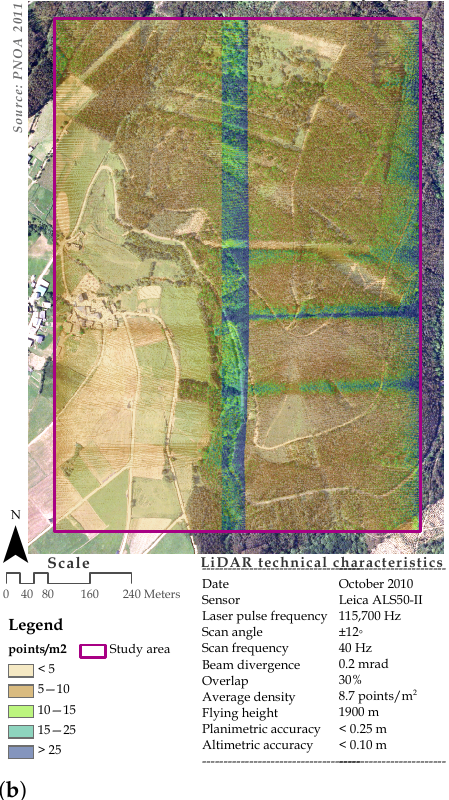
Figure 2. ( a ) Study area and reference roads. Source: PNOA@Instituto Geográfico Nacional de Sede Electrónica del Catastro—https://www.sedecatastro.gob.es/. ( b ) Technical characteristics of LiDAR data